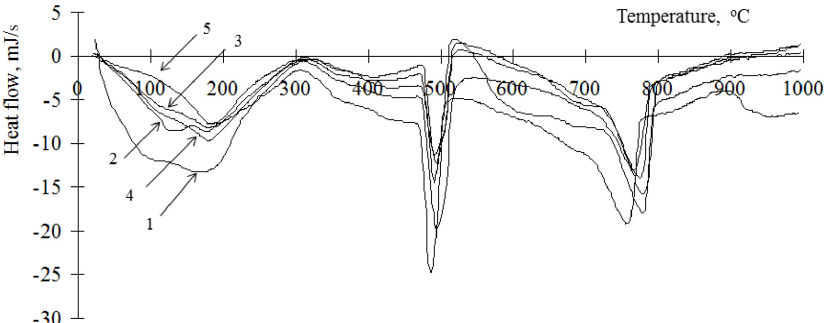
Figure 1. Thermogram of a cement stone modified with barium hydrosilicates and zinc hydrosili- cates (0.5%): 1—at the age of 1 day; 2—at the age of 3 days; 3—at the age of 7 days; 4—at the age of 14 days; 5—at the age of 28 days.